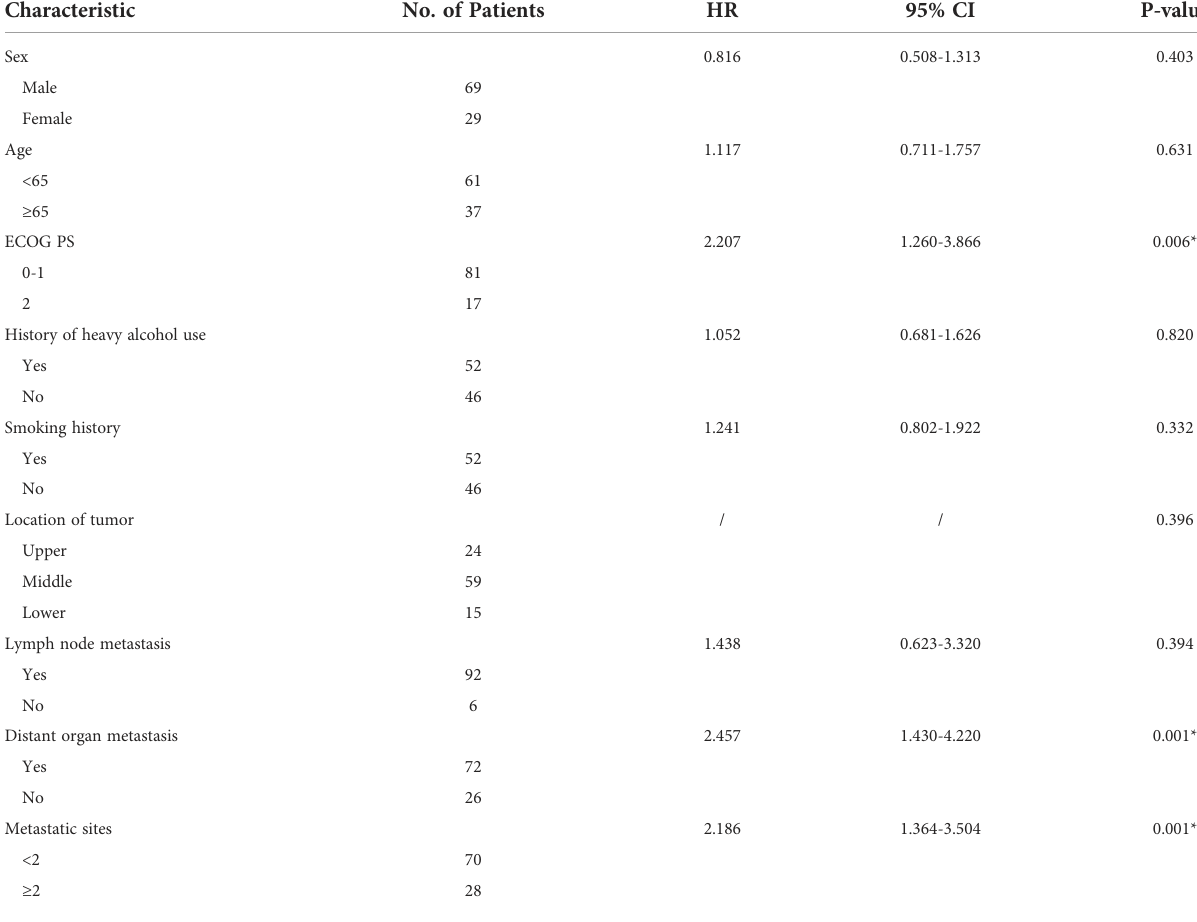
TABLE 7 Univariate analysis of PFS of 98 advanced esophageal squamous cell carcinoma patients. Characteristic No. of Patients HR 95% CI P-value